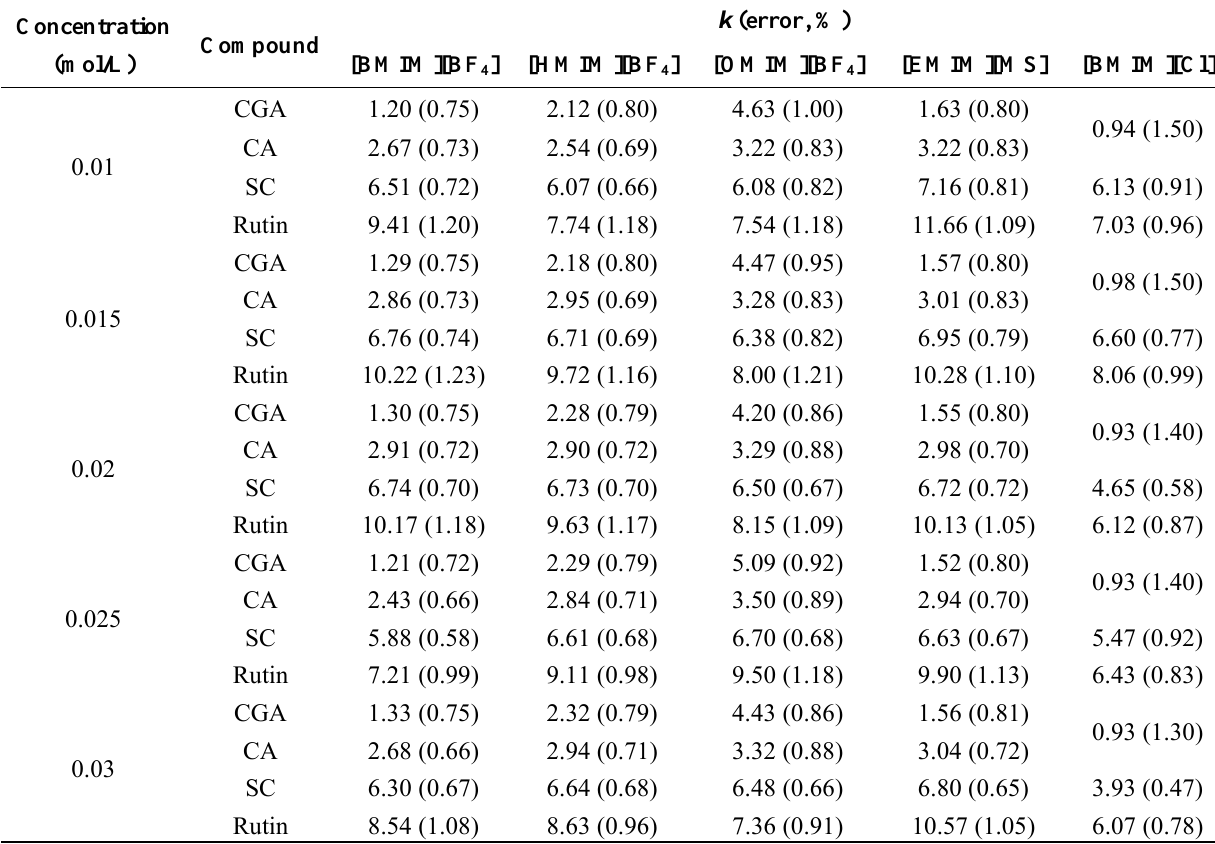
Table 2. Effect of the concentration of the different ionic liquids on retention